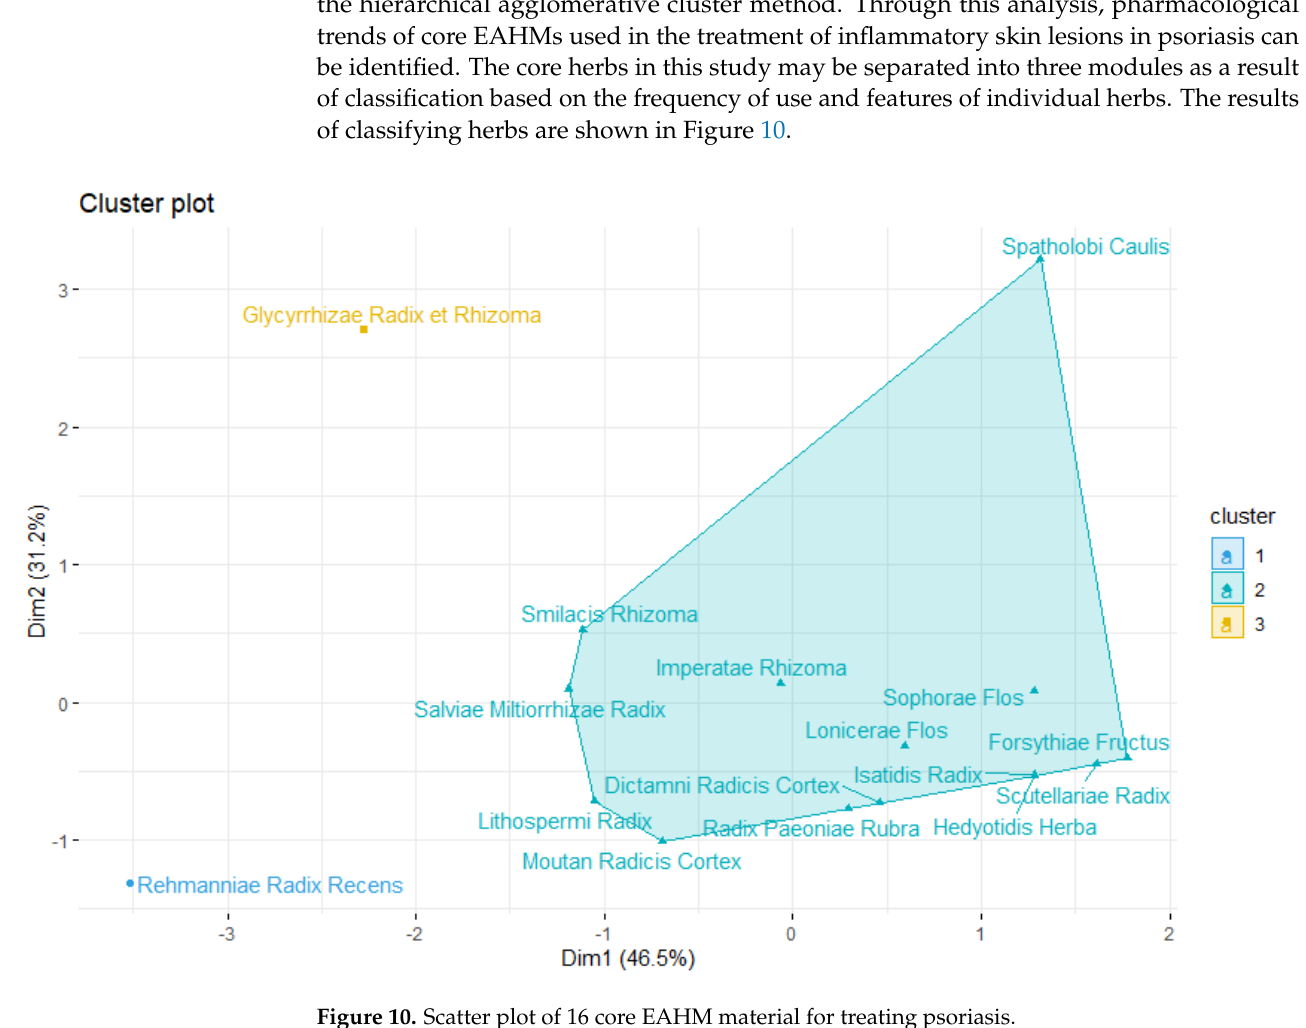
Figure 10. Scatter plot of 16 core EAHM material for treating psoriasis.